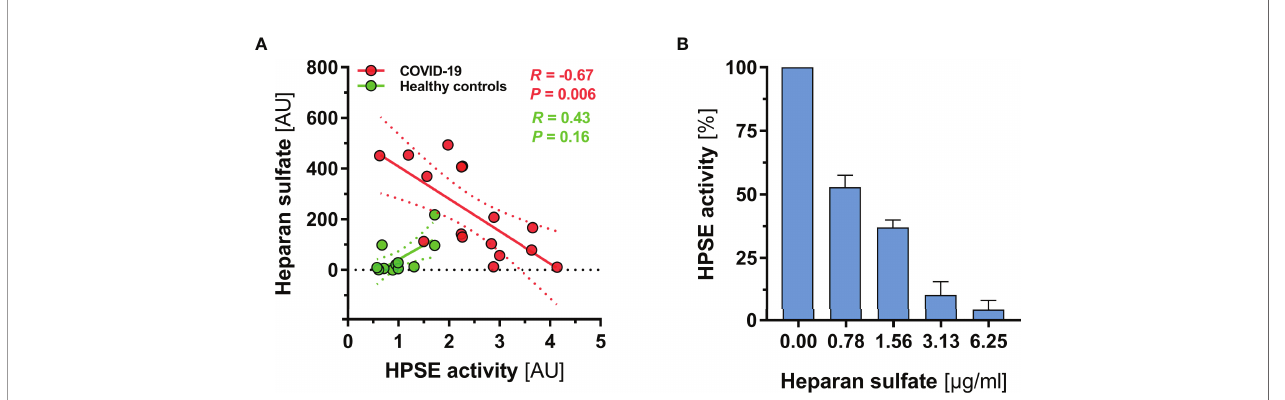
FIGURE 3 | HS fragments in severe COVID-19 may partially block HPSE activity. (A) Scatter dot plot showing regression slopes of HPSE activity vs . HS plasma concentration in healthy subjects (n = 12) and COVID-19 patients (n = 16), respectively. (B) Bar charts showing percentage decrease of HPSE activity with increasing amounts of HS (isolated from bovine kidney) in three independent experiments. For this experiment, recombinant human HPSE was used in a concentration of 150 ng/ml. Data are presented as mean